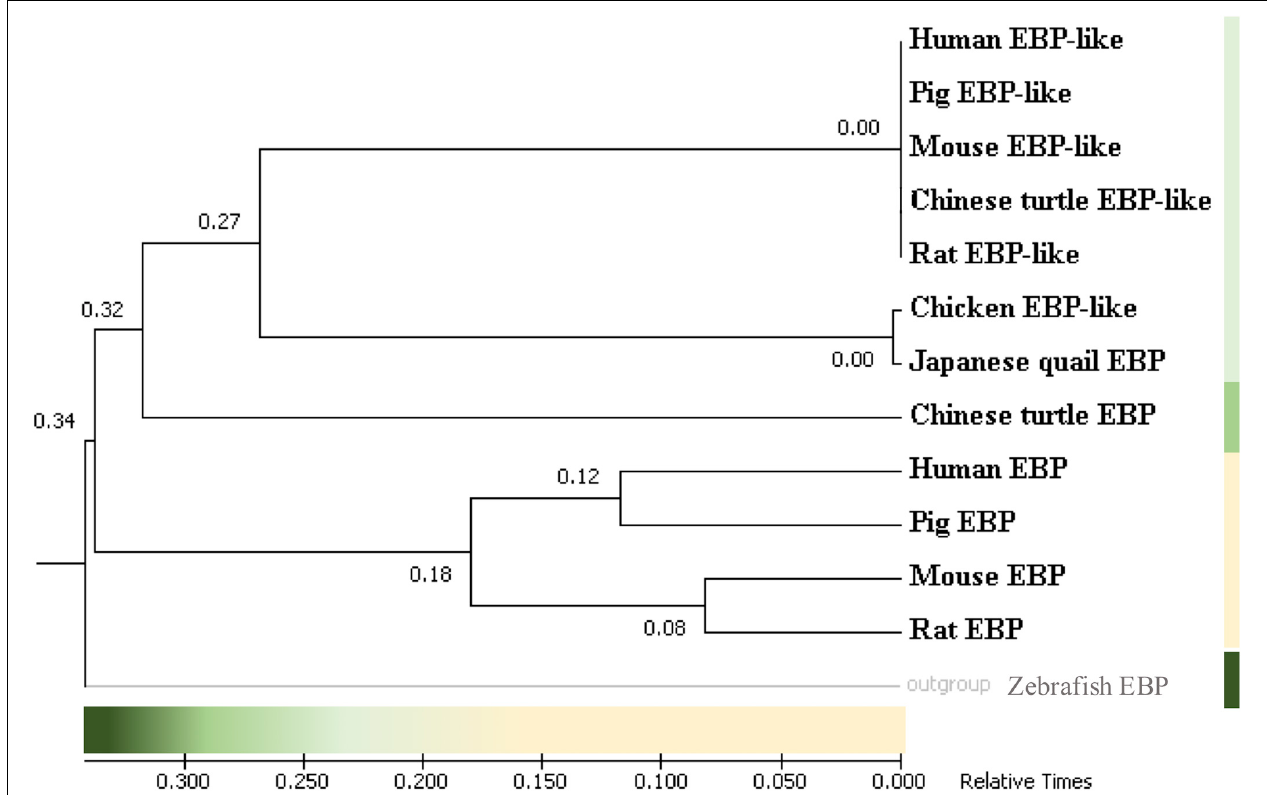
FIGURE 1 | Phylogenetic relationship analysis of EBP / EBP-like . Time-scale tree for the evolution of EBP / EBP-like gene. The tree was rooted by using zebrafish EBP as an outgroup. The relative gene duplication times are shown in × 1,000 millions years ago.